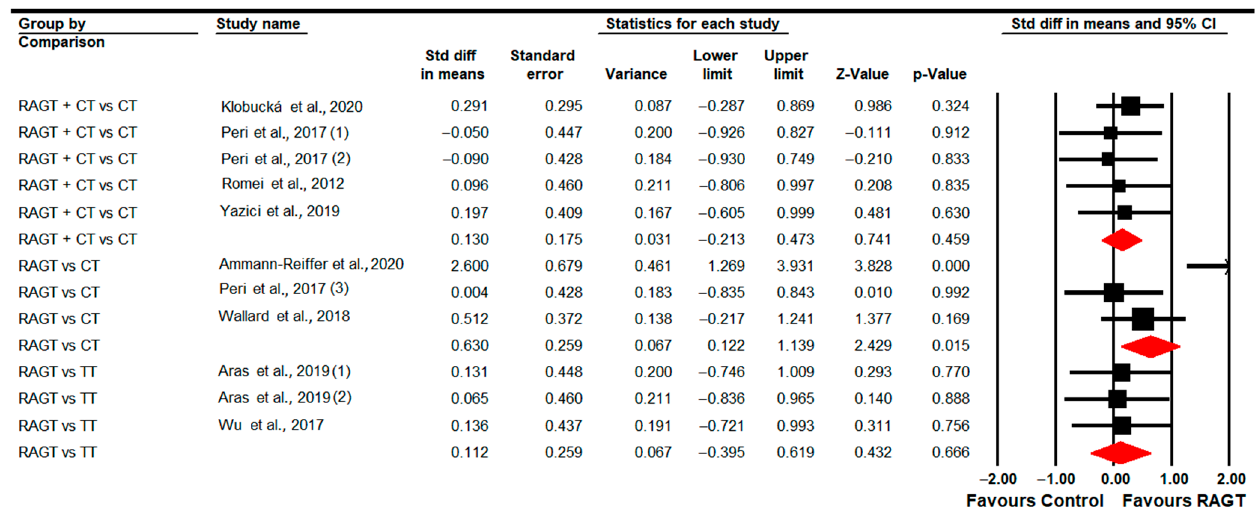
Figure 8. Forest Plot of Standing Ability (Post-Intervention Assessment) [78,79,81,83,84,87,89,91].